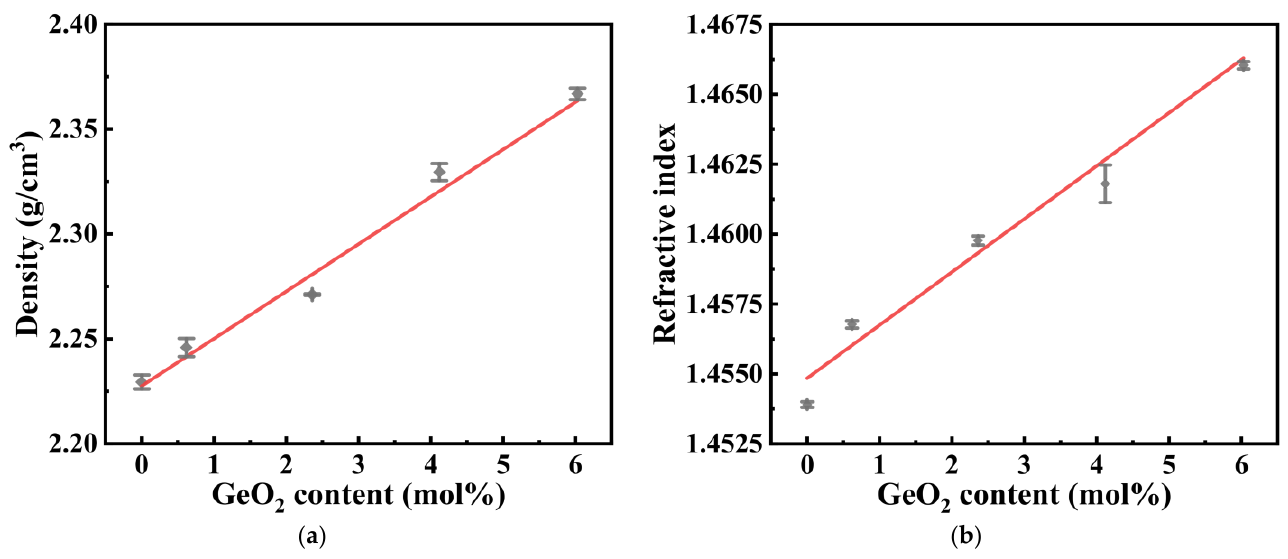
Figure 1. ( a ) Density and ( b ) refractive index of GAY samples.